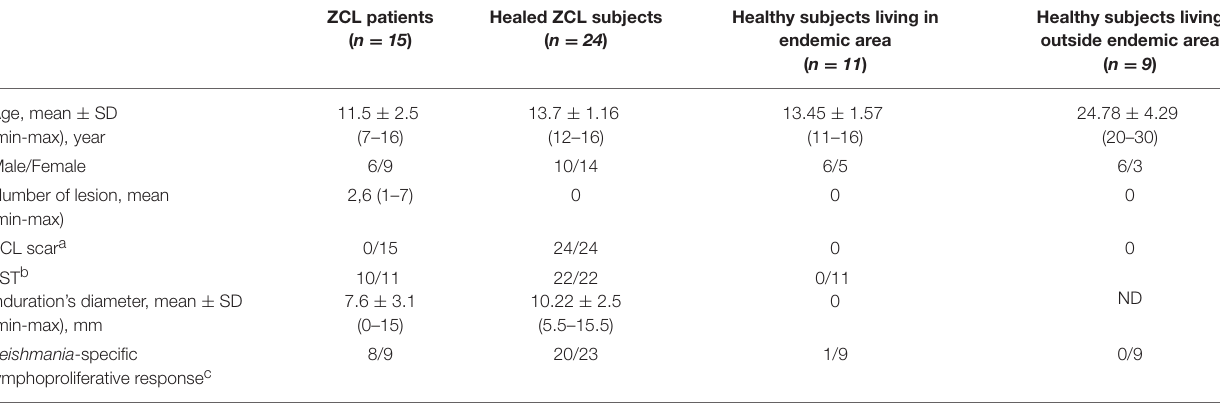
TABLE 1 | Clinical and immunological data of subjects included in the study.